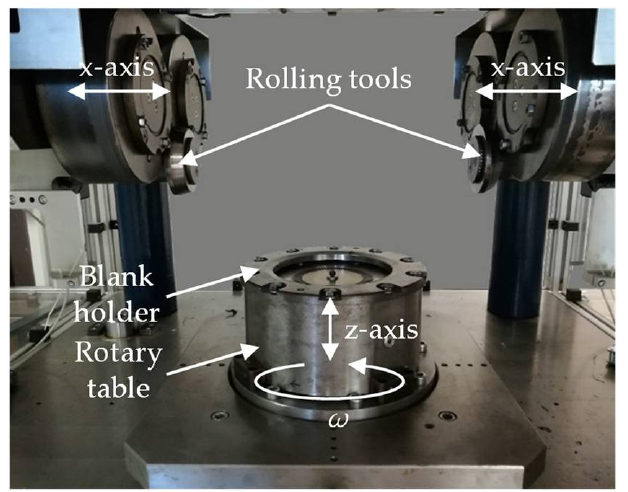
Figure 8. Process setup of flexible rolling [8].